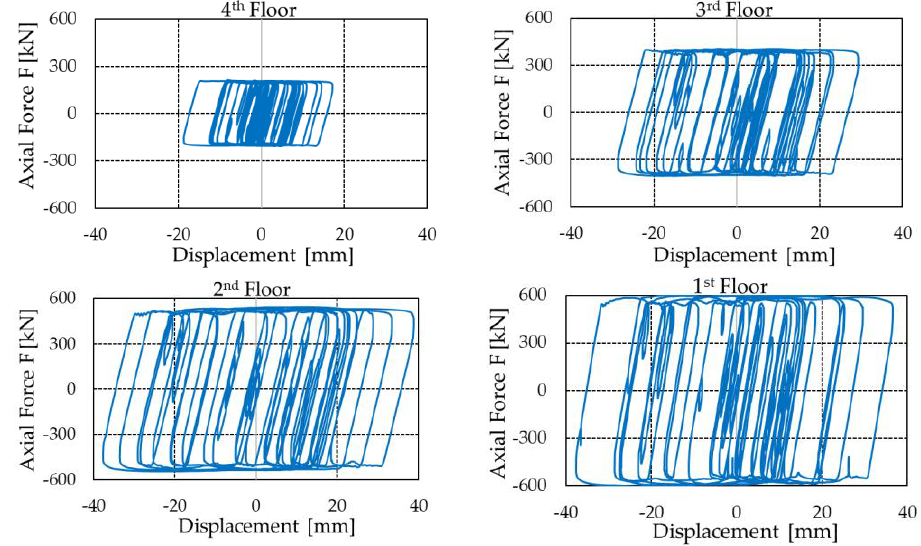
Figure 23. Force–displacement cycles of the PS-LED dampers at each floor of the steel MRF calculated for the most demanding input